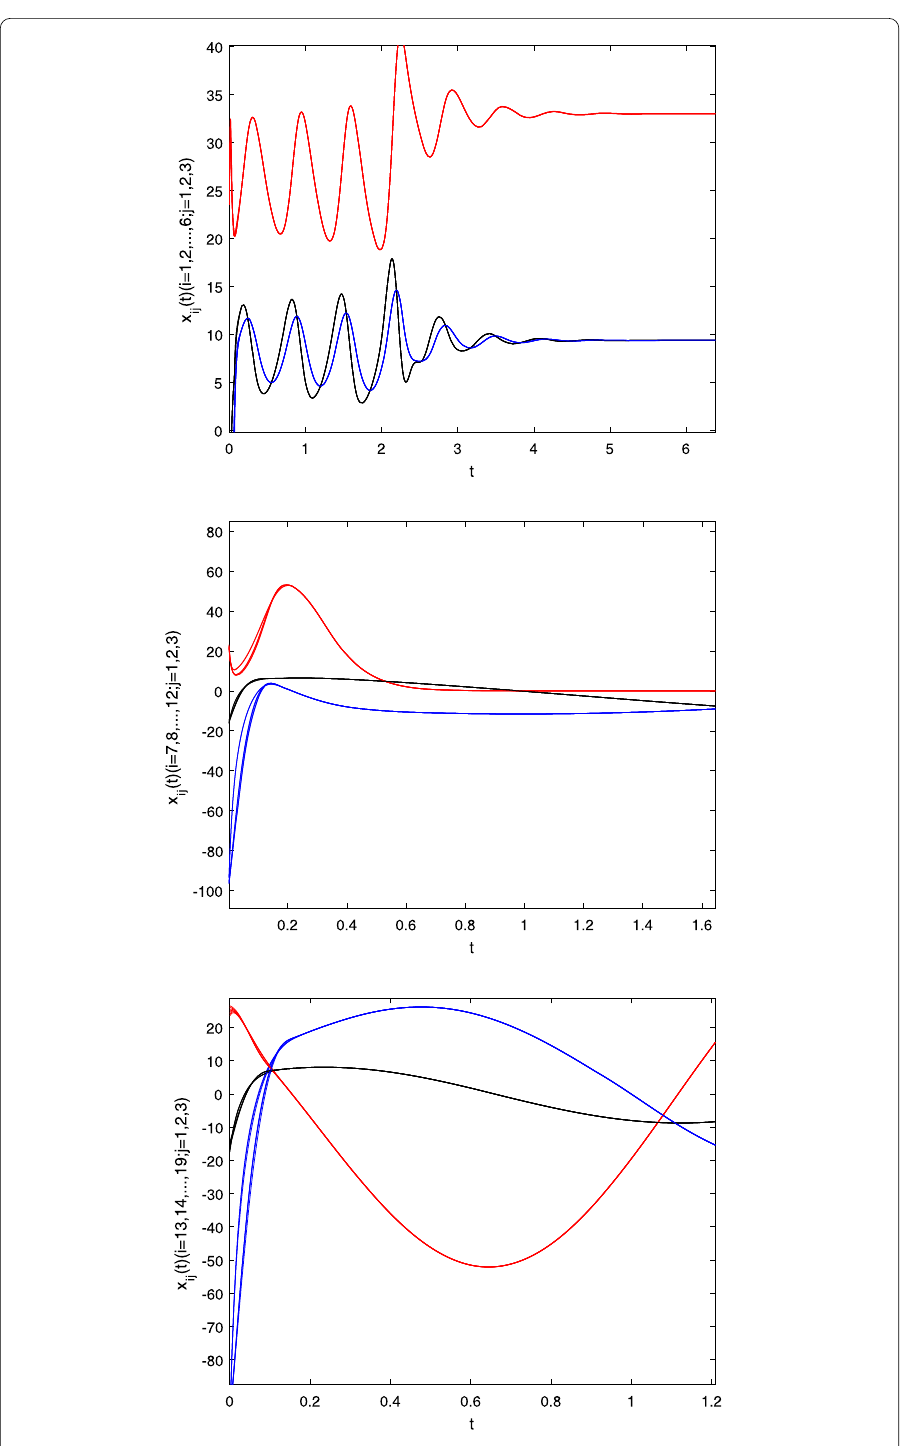
Figure 6 The time evolutions of nodes of three clusters